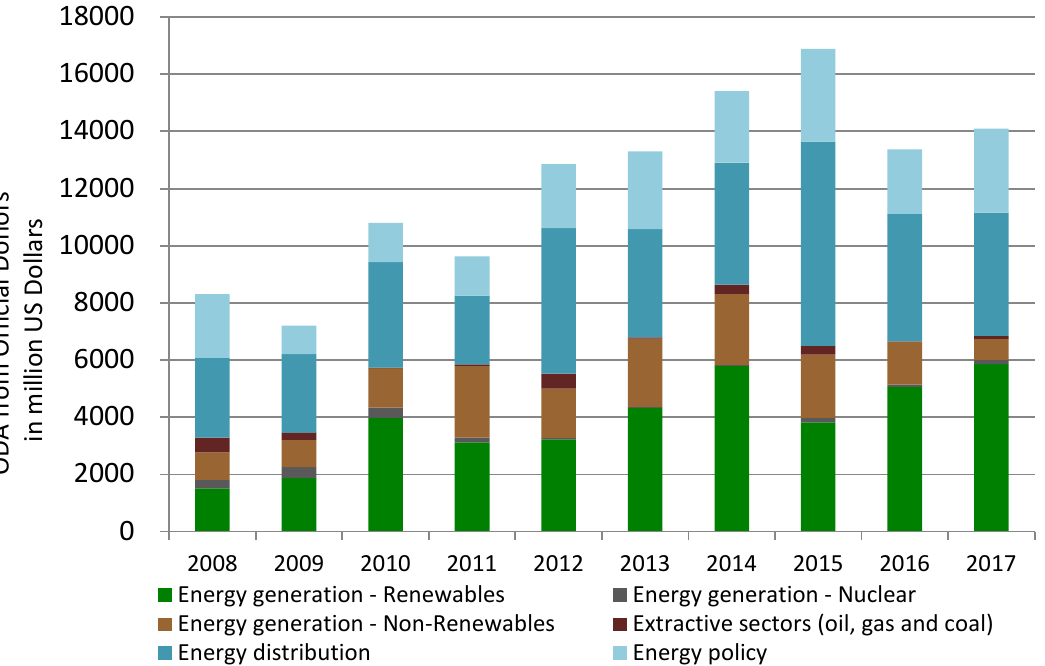
Figure 2 : Overseas development assistance from official donors in the energy